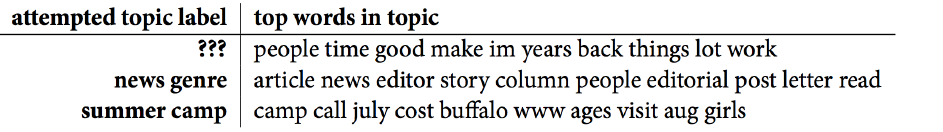
Figure 2. Examples of rejected candidate topics from 45 topic solution. Ten most likely words for each topic listed to right of attempted topic label.